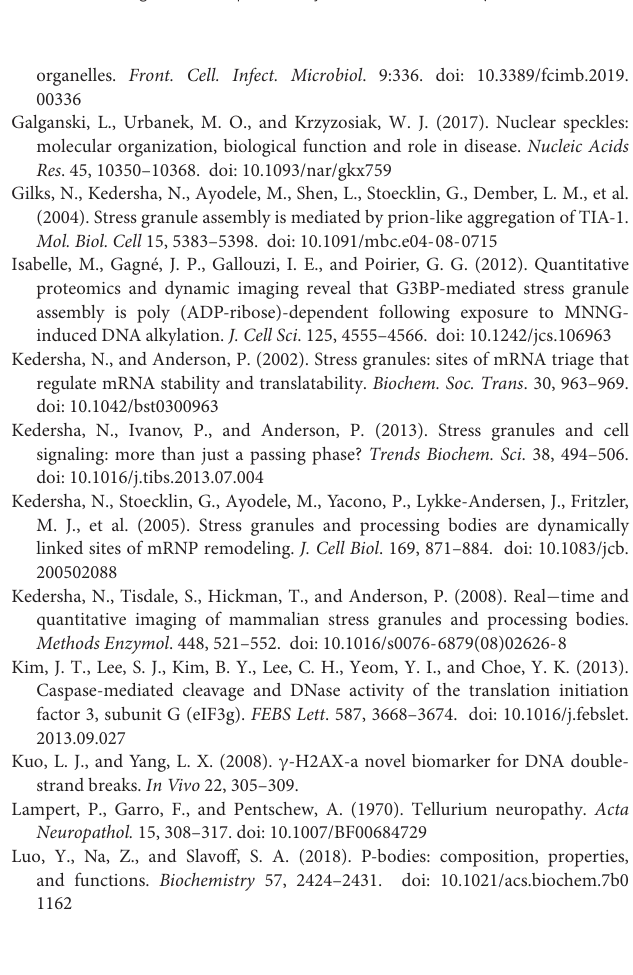
Supplementary Figure 1 | Tellurite treatment induces cytoplasmic stress granules (SGs) and nuclear SG-like assembly. (A) U2OS GFP-G3BP-1 cells were treated with 0.8 mM tellurite for 3, 6 or 12 h and immunostained for eIF3b (yellow). Images are representative from 2 different experiments. (B) Quantification of the fraction of SG-positive cells in the presence of 0.6 mM of tellurite (K 2 TeO 3 ) at 3, 6, or 12 h. Data represented as means ± SD ( ∗∗∗∗ p < 0.0001 relative to untreated cells by unpaired t -test). (C) Quantification of subcellular location of tellurite-induced SGs was performed and plotted as fraction of cells with only cytoplasmic SGs (black), both cytoplasmic and nuclear SGs-like (white) and only nuclear SGs-like (gray). Data represent 45 cells analyzed per condition. Supplementary Video 1 | Live cell microscopy of tellurite-induced SGs and SG-like dynamics. U2OS GFP-G3BP-1 cells were treated with 1 mM tellurite for 140 min and images were acquired every 2 min. Scale bar: 20 µ